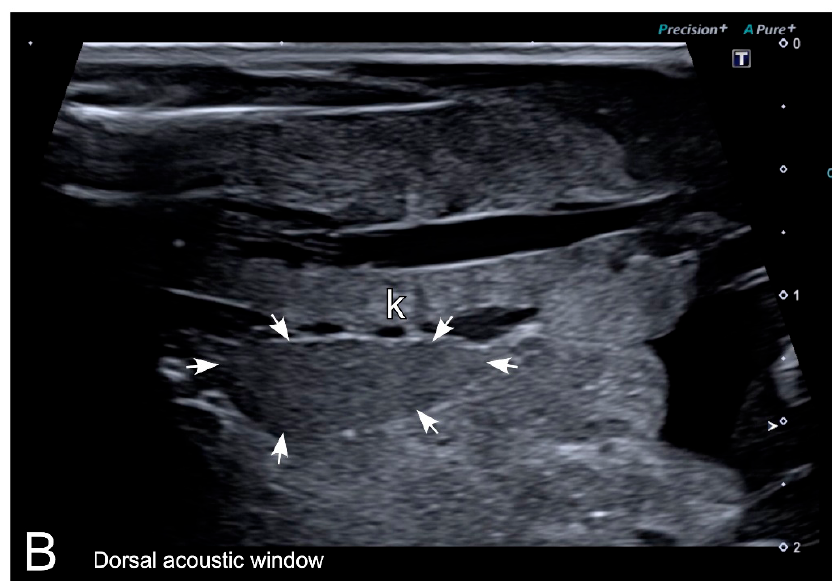
Figure 7. Representative HR-US images of Kaloula pulchra ( A ) and Xenopus laevis ( B ) males obtained in the longitudinal plane using a dorsal acoustic window. The testes (delimited by arrows) appeared as structures with oval morphology, mid echogenicity and homogenous echotexture. Testes were located just ventral or ventrolateral of the ipsilateral kidney (k).